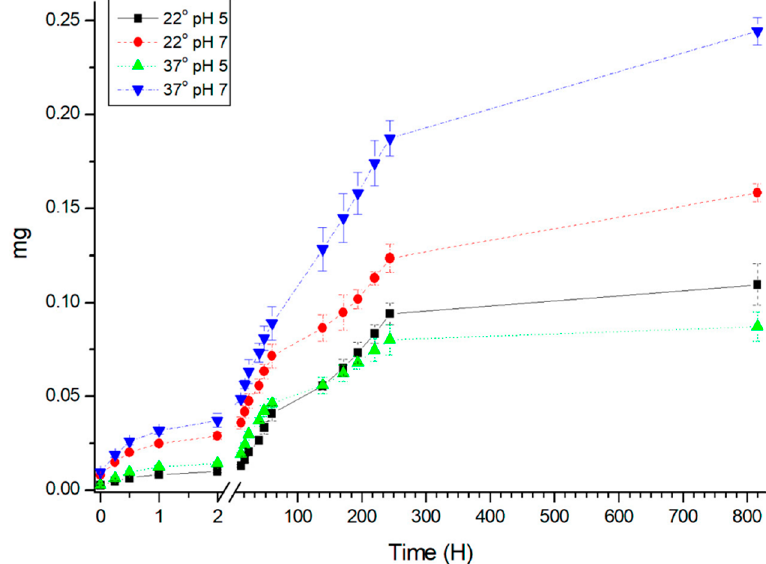
Figure 2. Dependence of the mass of the FITC-labeled PAH in the supernatant versus time incubation of polyelectrolyte microcapsules, the envelope of which contains FITC-labeled PAH at room temperature (22 ◦ C) and at 37 ◦ C, at pH 5 and 7.4. 1—pH 5, 22 ◦ C; 2—pH 7.4, 22 ◦ C; 3—pH 5, 37 ◦ C; 2—pH 7.4, 37 ◦